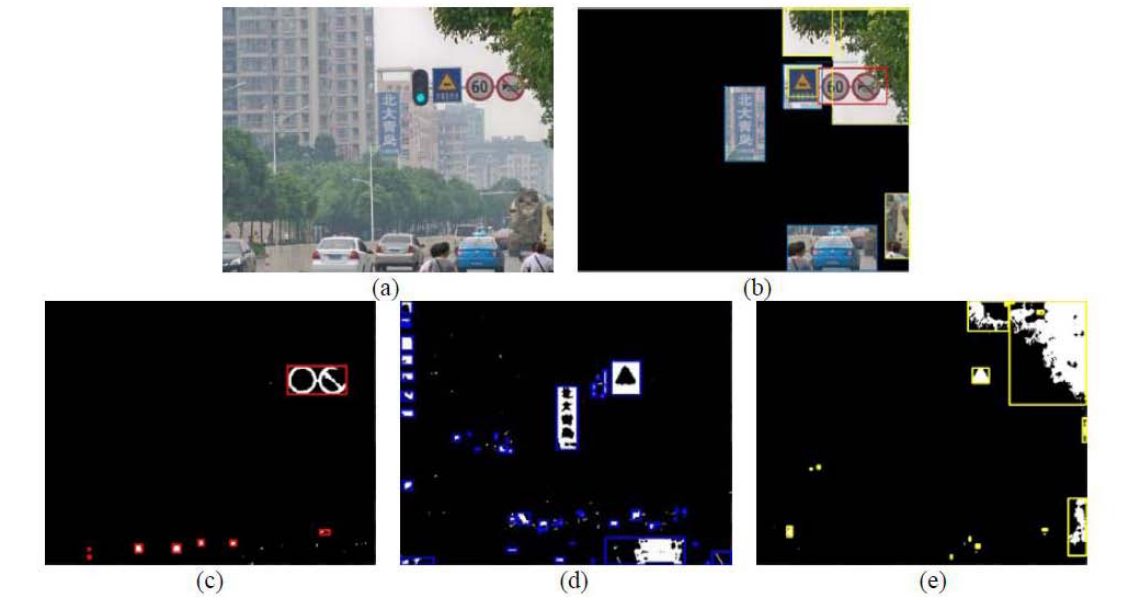
Figure 9. Color quantization and ROI locking. ( a ) original image, ( b ) ROI locking, ( c ) red segmentation, ( d ) blue segmentation, ( e ) yellow